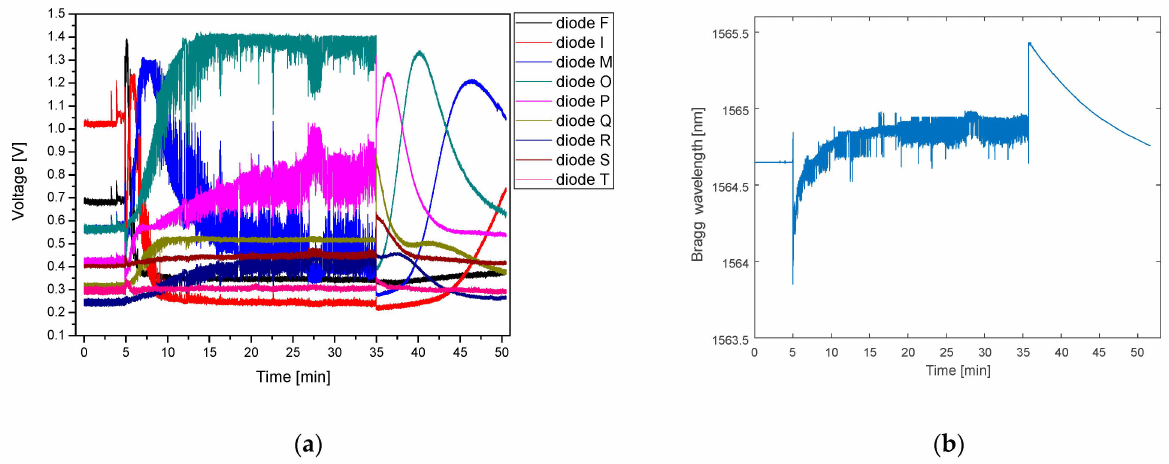
Sensors 2021 , 21 , x FOR PEER REVIEW Figure 12. Regular breathing and effect of FBG heating up captured by ( a ) PIC interrogator; ( b ) Ibsen I-MON 256 interrogator.